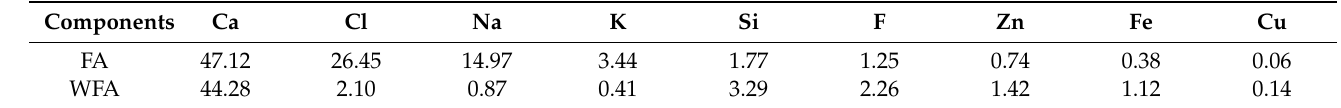
Table 1. Main elementary components of FA and WFA used in the sintering experiments (mass, %). Reprinted with permission from Elsevier, 2022 [32].